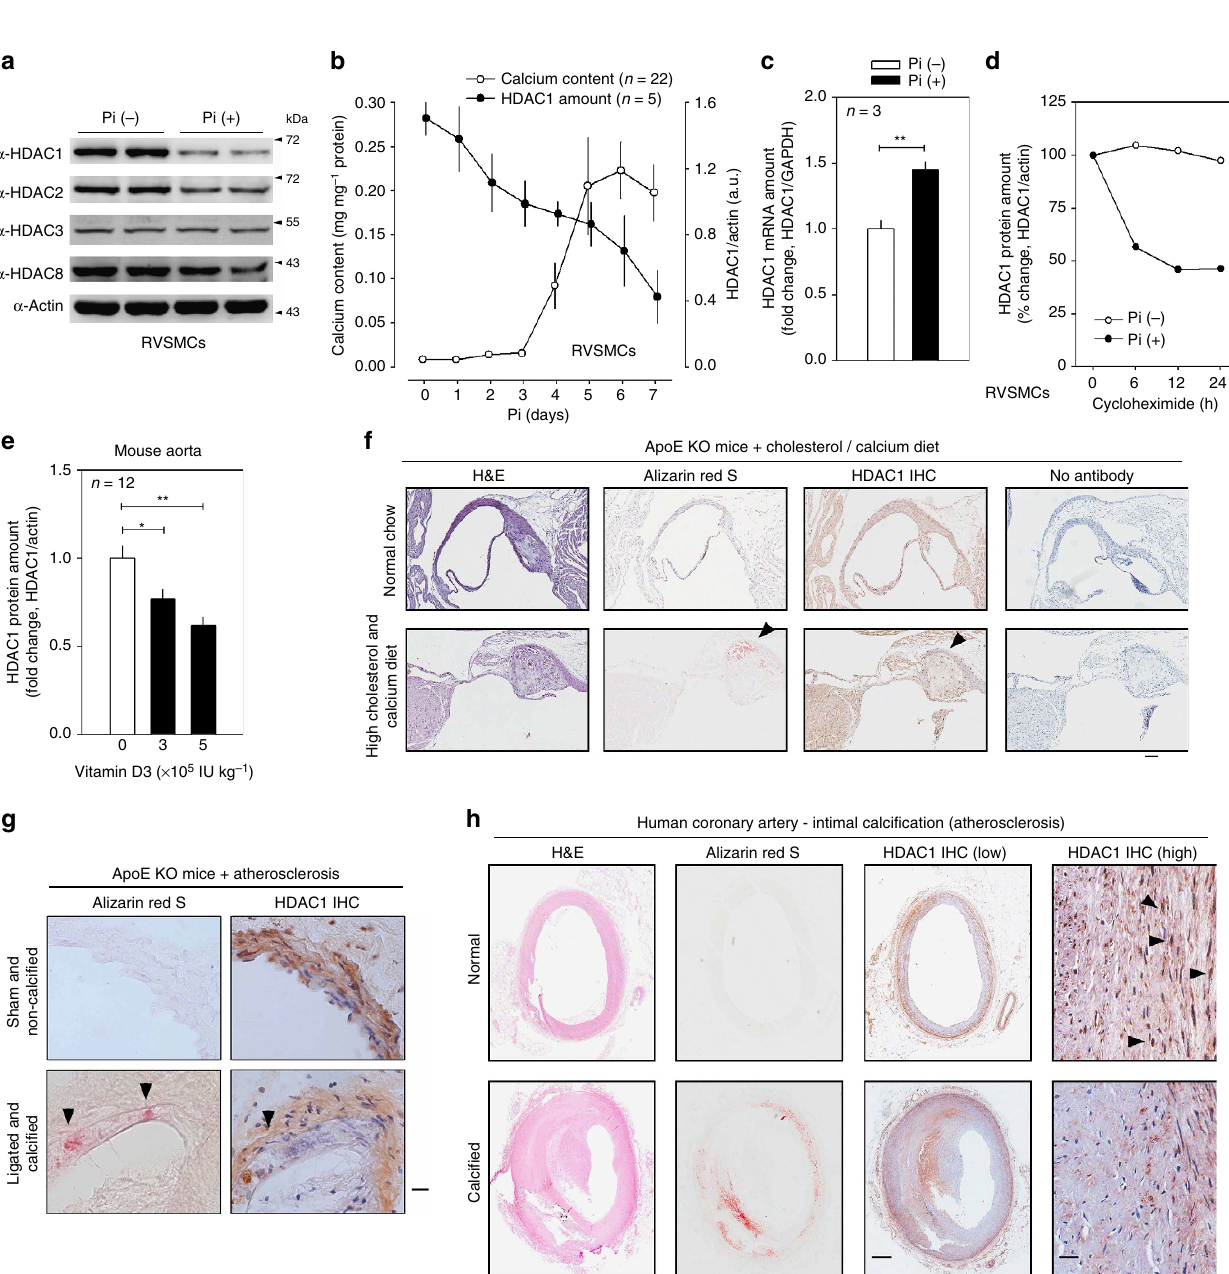
Figure 3 | HDAC1 protein, but not mRNA, is reduced in VC. ( a ) Among the class I HDACs, HDAC1 and HDAC2 protein amounts were reduced by Pi treatment. ( b ) Time course of calcium deposition (open circle) and HDAC1 protein reduction (black circle). Note that HDAC1 protein reduction precedes substantial increase in calcium content. Calcium contents were measured in 22 samples from six sets and quantification results of HDAC1 protein amounts were obtained from five samples out of three independent sets of experiments. ( c ) Changes in HDAC1 mRNA levels. mRNA content was determined with quantitative real-time RT–PCR. Each sample was measured in duplicate and counted as one case ( n ¼ 3 from one set). ( d ) Cycloheximide (CHX) chase study elicited enhancement of HDAC1 protein decay by Pi. After treatment with Pi (2mM, 6 days), 20 m gml (cid:2) 1 CHX was treated for the indicated interval. Values were averaged from two experiments. ( e ) VD 3 significantly reduced the protein amount of HDAC1 in the aorta in a dose-dependent manner. Quantification results from 12 western blots from four independent experimental sets. ( f ) Immunohistochemical analysis showed the reduction of HDAC1 in atherosclerosis-associated calcification mouse models. Ten-week-old ApoE knockout (KO) male mice were fed a high-cholesterol diet for 10 weeks followed by a high-cholesterol plus calcium diet for the next 7 weeks. The HDAC1 expression level was downregulated in the tissues adjacent to the calcified focus (arrowheads). Scale bar, 100 m m. ( g ) Immunohistochemical analysis showed a reduction of HDAC1 in an alternative atherosclerosis animal model. ApoE KO male mouse aorta was subjected to carotid artery ligation to induce sheer stress and atherosclerosis developed. Some mice showed calcified foci (arrowheads) adjacent to the atherosclerotic plaque where HDAC1 expression was lowered. Scale bar, 25 m m. ( h ) HDAC1 protein level was downregulated in atherosclerosis-associated human coronary artery. Arrowheads indicate HDAC1-positive nuclei. Scale bar, 500 m m (low